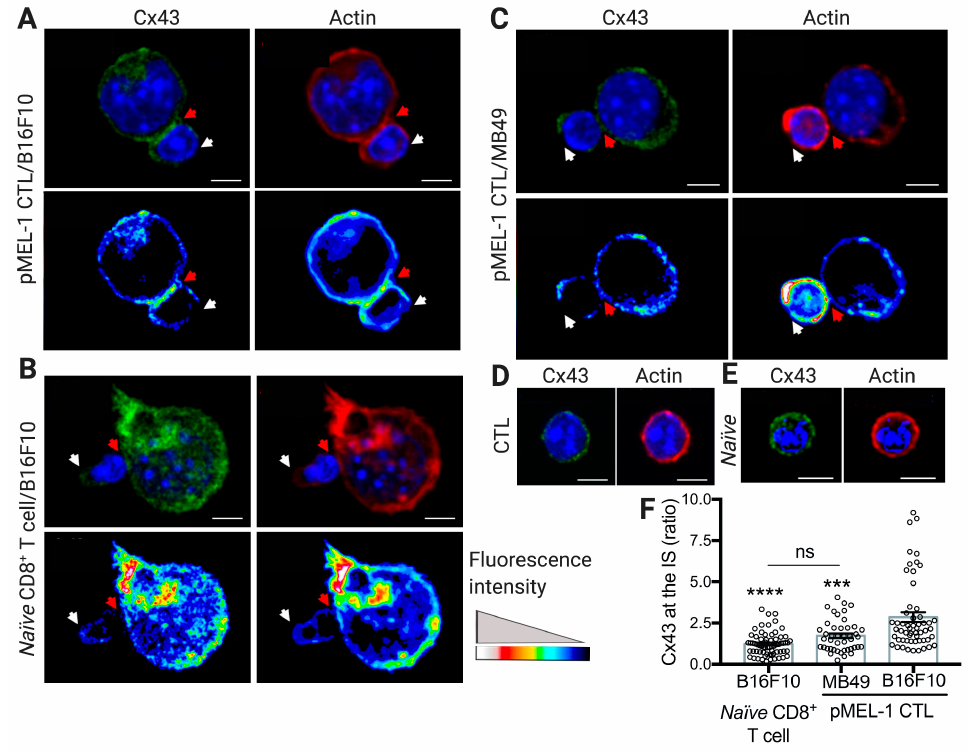
Figure 1. Connexin-43 (Cx43) accumulates at the pMEL-1 cytotoxic T lymphocyte (CTL) / B16F10 melanoma cell contact site upon cytotoxic immunological synapse (IS) formation. Representative images for cell conjugates formed after 30 min of co-culture of pMEL-1 CTLs or naïve CD8 + T cells with wheat germ agglutinin (WGA) pre-loaded (not shown) target ( A , B ) B16F10 cells or ( C ) MB49 cells. The distributions of both Cx43 (green) and F-actin (rhodamine-phalloidin, red) at the cytotoxic IS are indicated by red arrows and were analyzed by immunofluorescence and confocal microscopy. ( A – E ) Hoechst nuclear staining is shown in blue. Representative images of Cx43 and actin staining in ( D ) unconjugated pMEL-1 CTL and ( E ) naïve CD8 + T cell. ( A – C ) Pseudocolor images for the distribution of Cx43 and F-actin are shown at the bottom of each figure. ( A – E ) Scale bars = 5 µ m. ( F ) Quantification of Cx43 accumulation at the cytotoxic IS as ratio of Cx43 fluorescence intensity in the cell-cell contact site (red arrows) versus the opposite site (white arrows). *** p < 0.001, **** p < 0.0001, versus CTL / B16F10 conjugates; ns, non-significant (one-way ANOVA, Tukey’s multiple comparison test); n = approximately 60 cell conjugates by condition, two independent